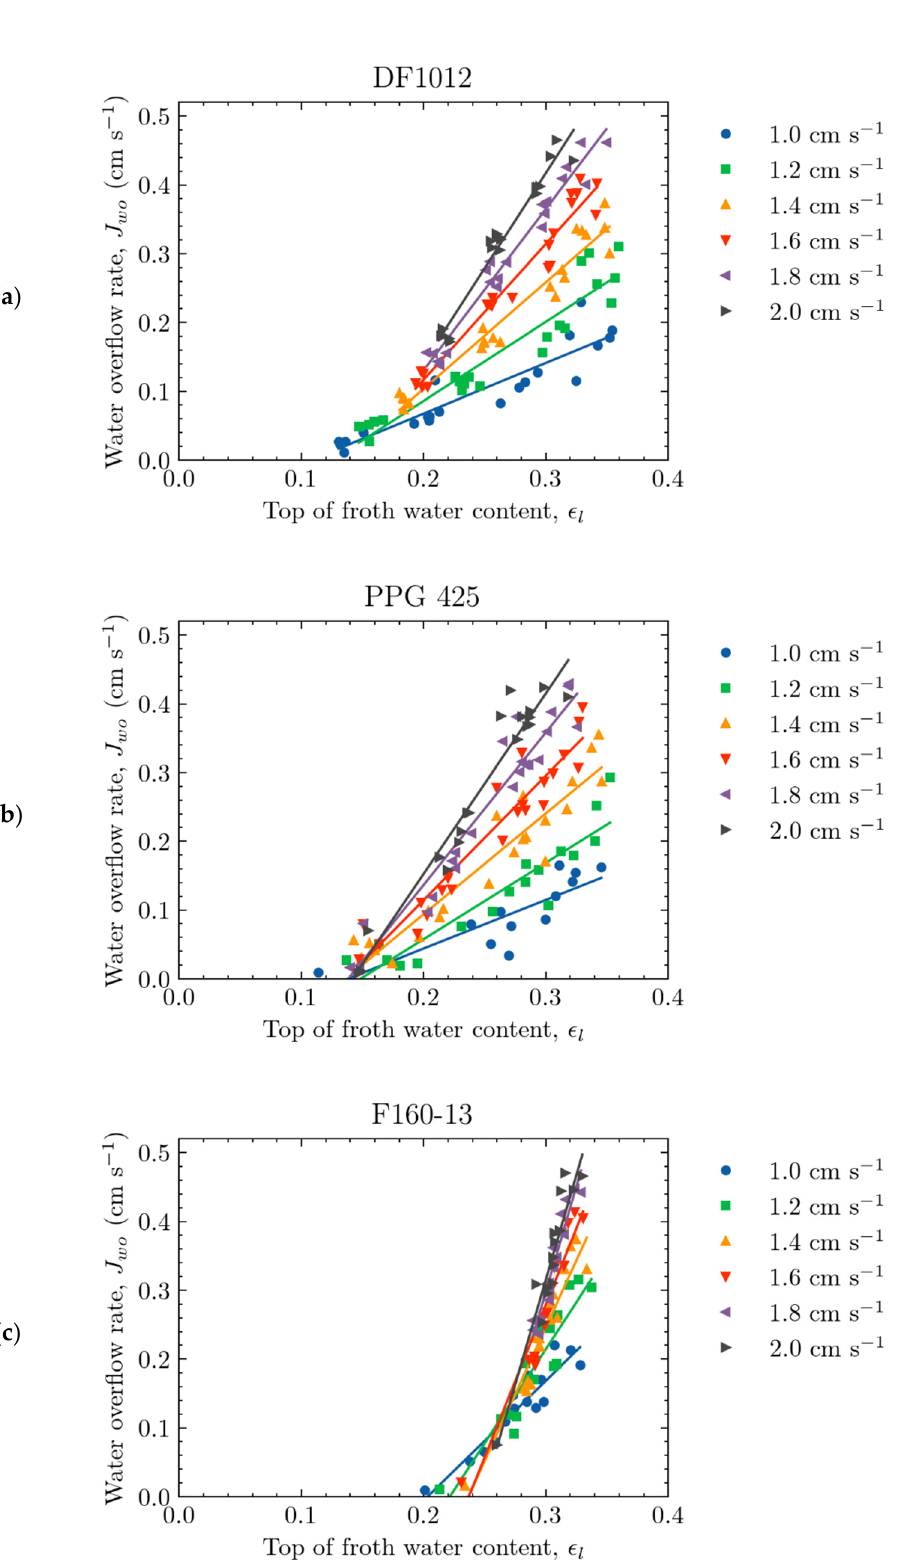
Figure 12. Relationship of froth zone water content and water overflow rate for ( a ) PPG 425, ( b ) DF1012 and ( c ) F160-13. Different data points at similar air rates were obtained by varying the frother concentration. Trend lines were added to add clarity to results, and do not imply a definitive model.